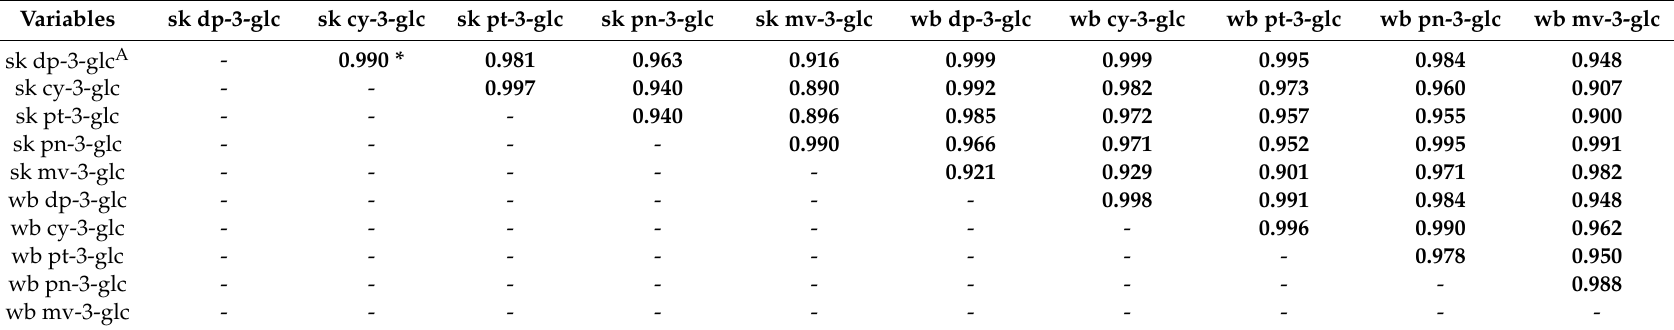
Table 3. Matrix of correlation coe ffi cients ( r ) of variables based on anthocyanin content (mg / kg fw) in the skin and whole berry in black ‘Isabel’ grape during berry development.